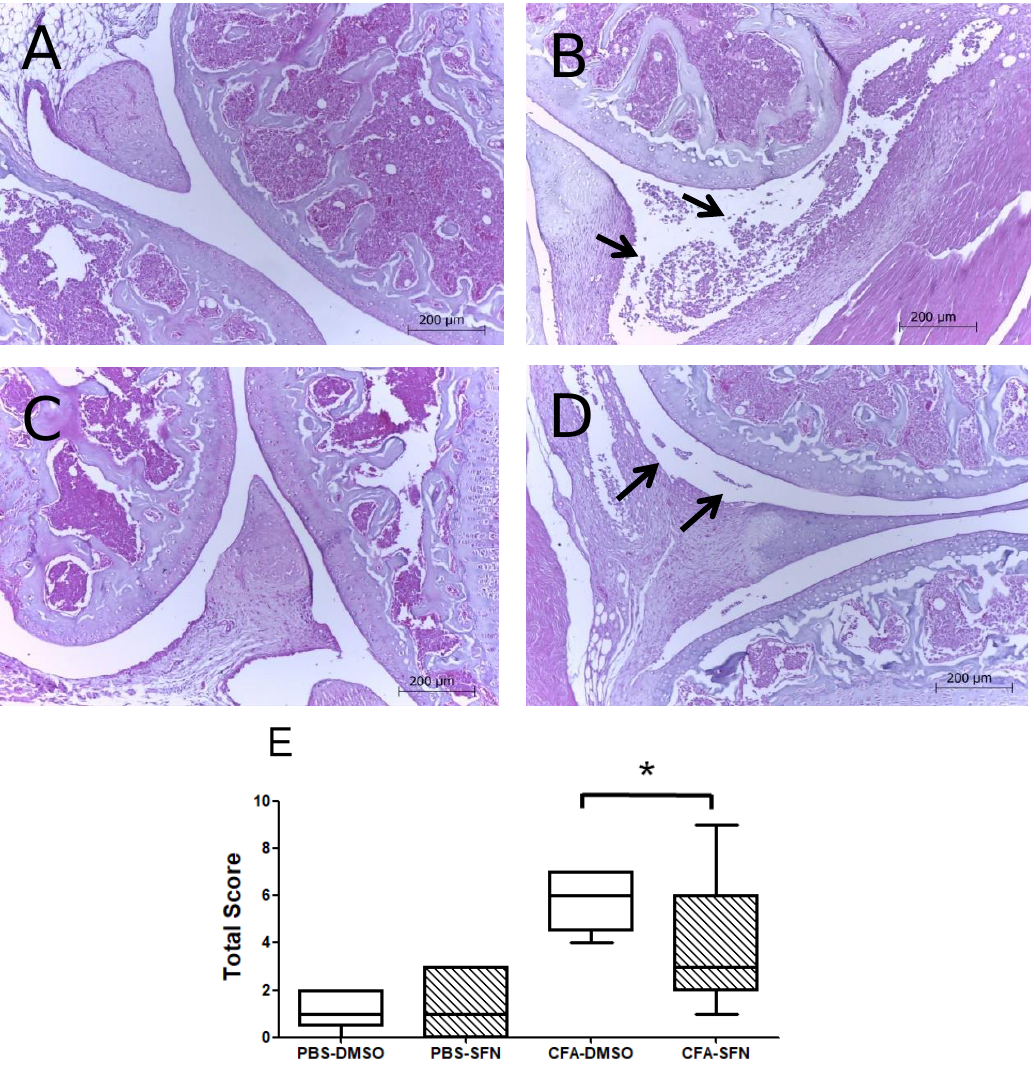
Figure 2. Effects of sulforaphane in attenuation of joint inflammation/damage caused by intra articular CFA-injection. Representative histologic sections of knee joints collected from animals with CFA-induced mono-arthritis ( n = 5/group). Panels: ( A ) morphological aspect of saline-injected joints treated with vehicle (DMSO), ( B ) morphological aspect of CFA-injected joints treated with vehicle (DMSO), ( C ) morphological aspect of saline-injected joints treated with SFN and ( D ) morphological aspect of CFA-injected joints treated with SFN. Arrows indicate the presence of cellular infiltrates in the synovial space of CFA joints. Sections were stained with hematoxylin and eosin. ( E ) Represents the sum of a 0–3-point score of knee joint inflammation scale used for each parameter: Synovial hypertrophy, cellular infiltration, cartilage destruction, bone erosion (0-normal, 1-mild, 2-moderate, 3-severe). The score of joint inflammation was denoted by the median (minimum-maximum) values. Experiments were performed with 5 animals per group. * p < 0.05.